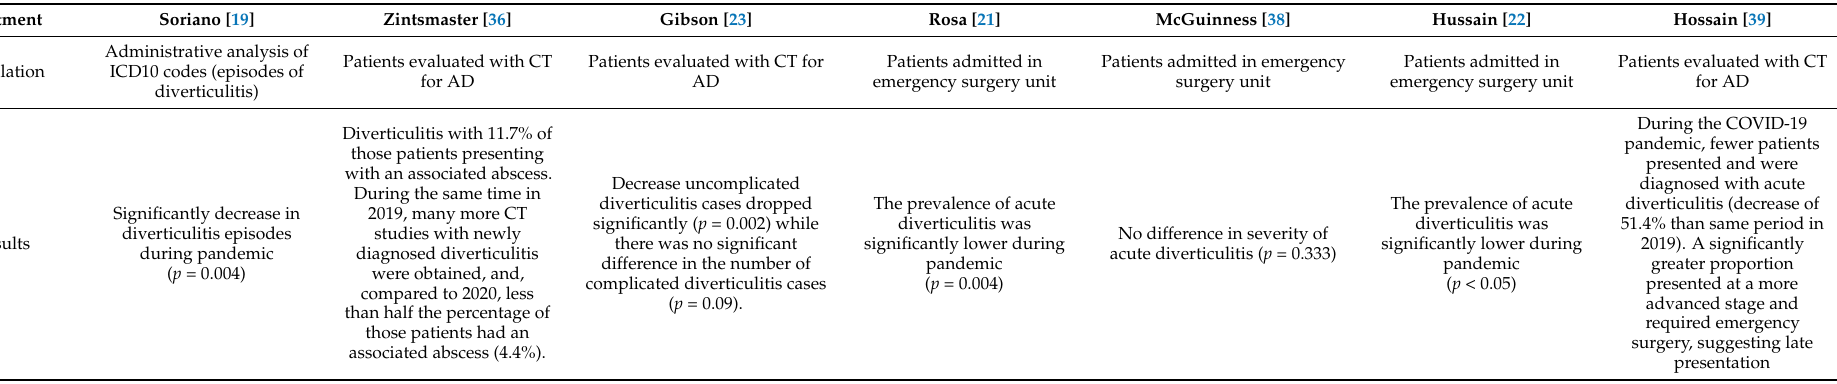
Table 4. Epidemiology evaluation of acute diverticulitis during COVID-19